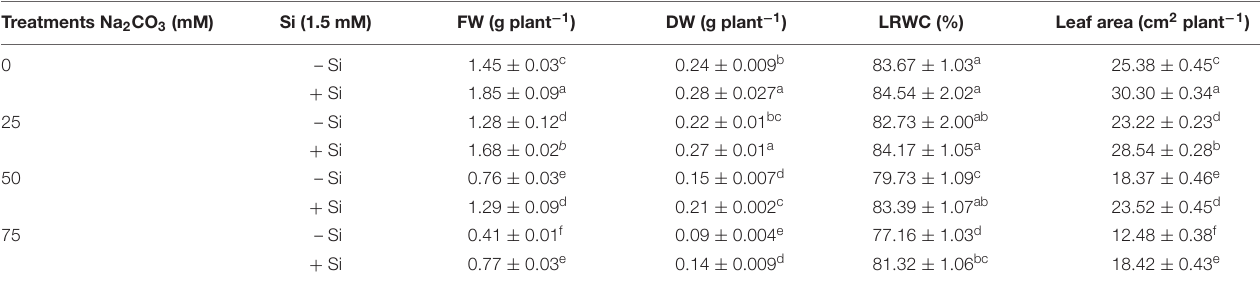
TABLE 1 | Effects of different levels of alkaline stress with and without seed-priming with silicon (Si) on fresh weight (FW), dry weight (DW), leaf relative water content (LRWC), and leaf area of 25-day-old maize plants. Treatments Na 2 CO 3 (mM)